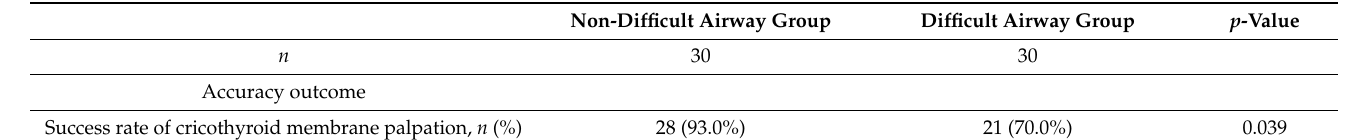
Table 2. Accuracy of cricothyroid membrane palpation according to the 3-3-2 rule for predicting difficult airway in female patients undergoing non-neck surgery.